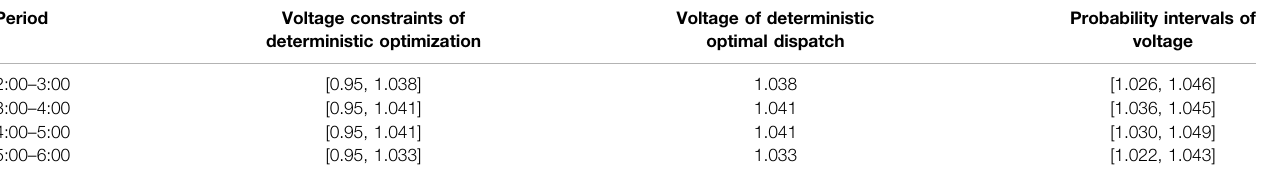
TABLE 3 | The same variables of 32-node in fi fth iteration.